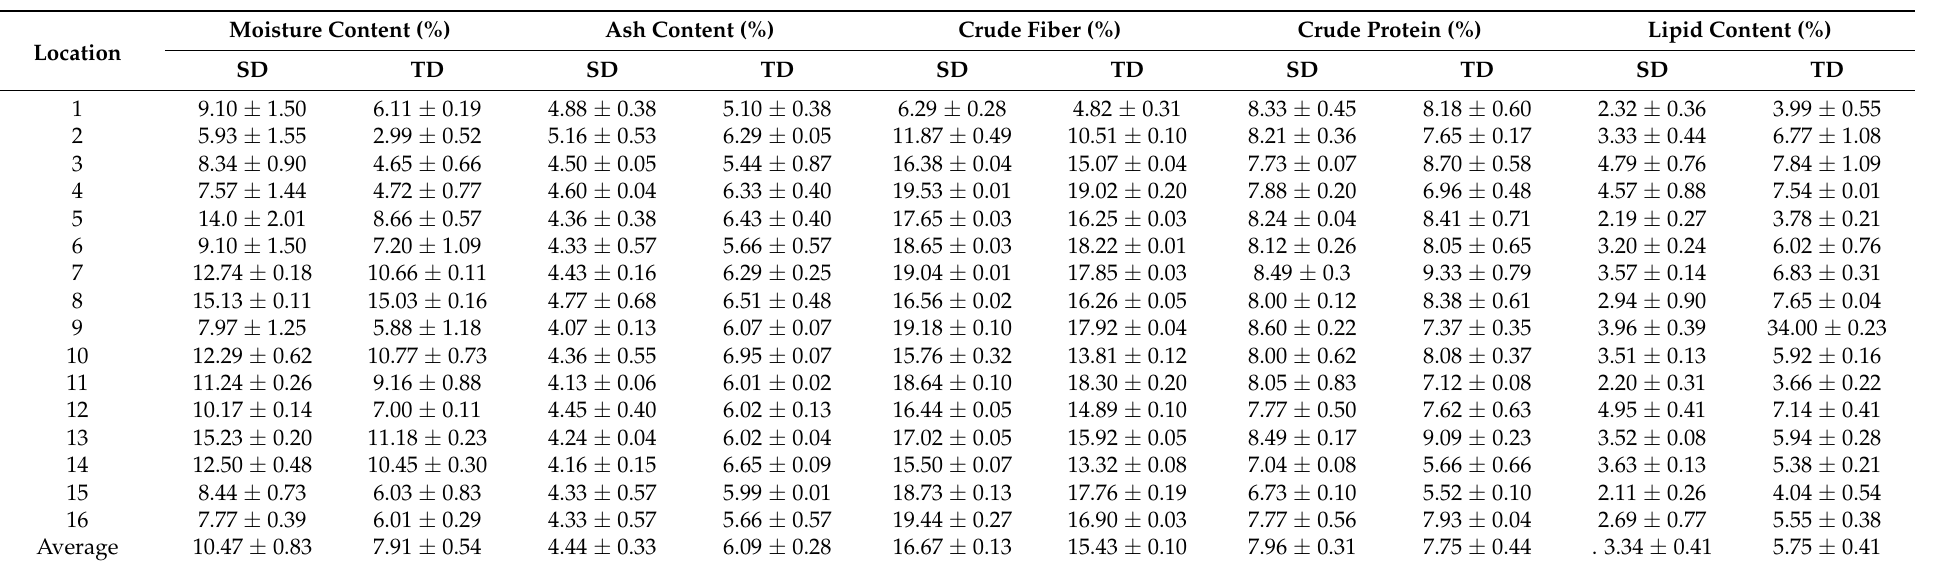
Table 1. Proximate composition of H. sabdariffa calyx. SD: shade dried; T.D: tray